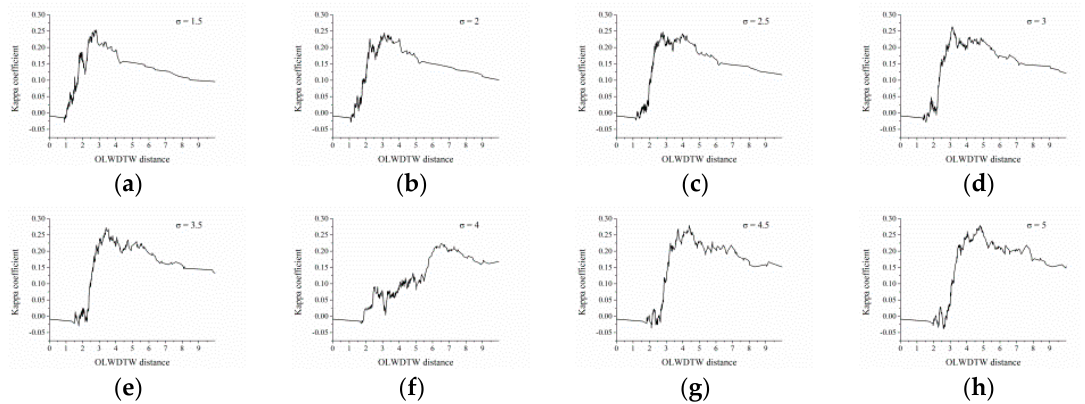
Figure 7. Kappa coefficient testing with different threshold values for OLWDTW distance with enhance factor σ : ( a ) σ = 1.5; ( b ) σ = 2; ( c ) σ = 2.5; ( d ) σ = 3; ( e ) σ = 3.5; ( f ) σ = 4; ( g ) σ = 4.5; ( h ) σ = 5. Table 4. Kappa coefficient and the corresponding OLWDTW distance under different enhance factor σ values of single-cropped rice paddies in test site 1.